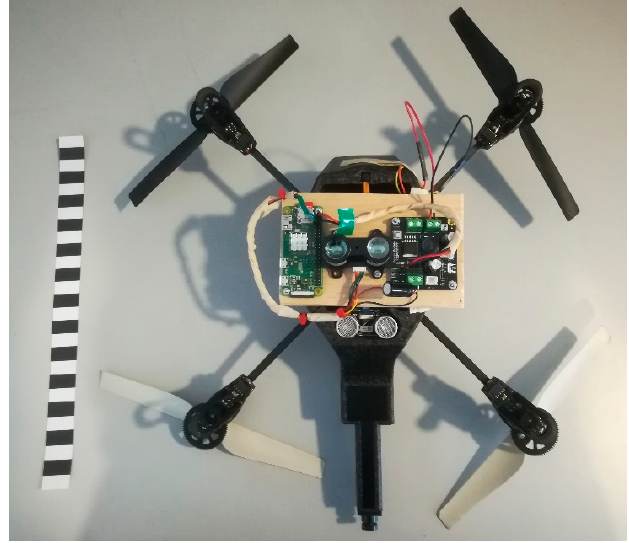
Figure 9. PODA platform (prototypical version) mounted onboard the quadcopter. Each square of the ruler on the left side of the image has 1-cm side length.